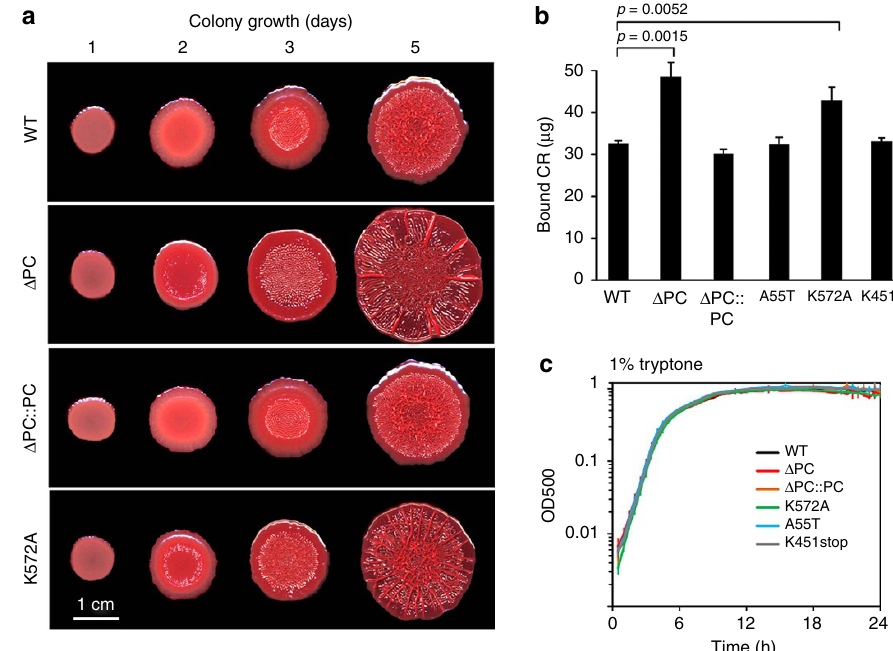
Figure 7 | PaPC dysfunction leads to increased matrix production and altered colony morphology. ( a ) Colony morphology of wild-type P. aeruginosa PA14, D PC , the PC-complemented strain and the K572A mutant on 1% tryptone, 1% agar (supplemented with Congo red and Coomassie blue). ( b ) Quantification of Congo red binding, a proxy for matrix production, for P. aeruginosa PA14, D PC , the PC-complemented strain and various site-specific mutants grown on 1% tryptone, 1% agar with no added dyes. Colonies were grown for 3 days before they were collected for the Congo red binding assay. ( c ) Shaken liquid-culture growth of P. aeruginosa PA14, D PC , the PC-complemented strain and various site-specific mutants in 1% tryptone. Each growth curve represents the average of three biological replicates. Error bars denote